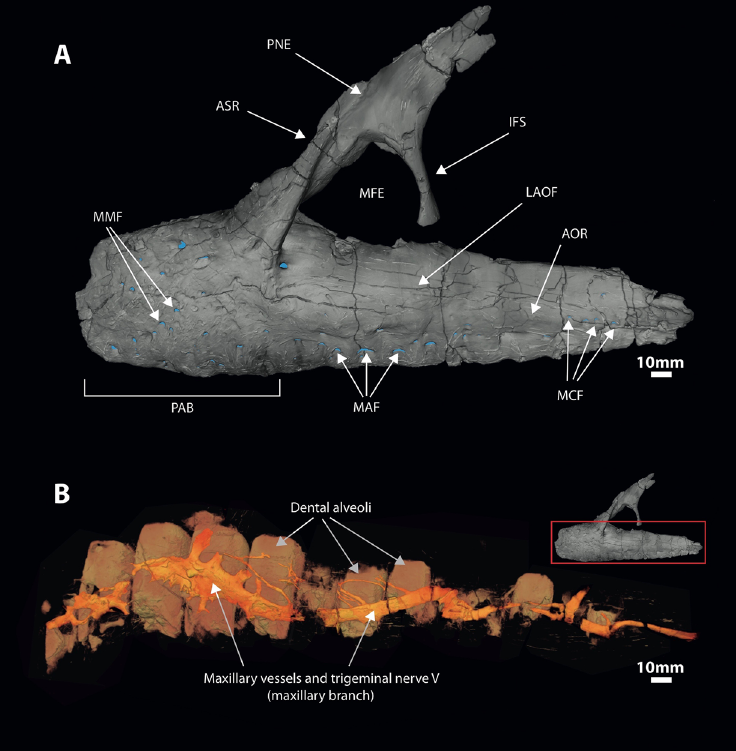
Figure 2. Complex anastomosing neurovasculature surrounding infilled dental alveoli of the maxilla of Neovenator . ( A ) Volume rendering of left maxilla in lateral view with foramina highlighted (blue). ( B ) Volume rendering of infilled voids. Abbrevations: aor : antorbital ridge; asr : ascending ramus; ifs : interfenestral strut; laof : lateral antorbital fossa; maf : maxillary alveolar foramina; mcf : maxillary circumfenestra foramina; mfe : maxillary fenestra; mmf : medial maxillary foramina; pab : preantorbital body; pne : pneumatic